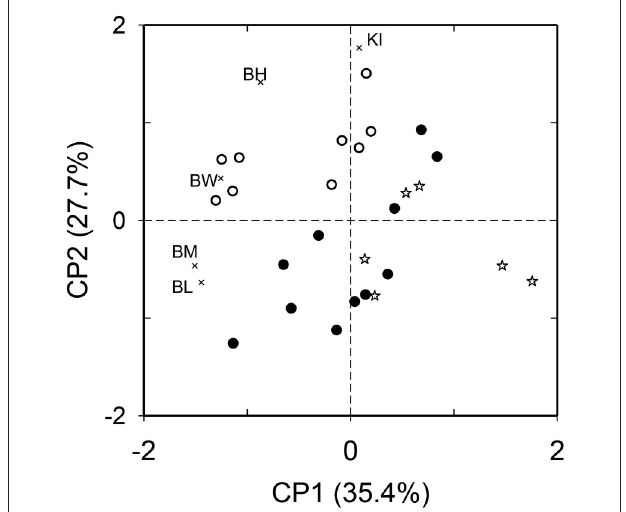
FIGURE 2 | Ordination of 26 bird species that consumed Podocarpus parlatorei fruits in the functional space defined by five morphological traits of size and shape (depicted with thin x; BM, body mass; BL, beak length to wing chord ratio; BW, beak width to wing chord ratio; BH, beak length to beak height ratio; KI, Kipp’s index) in a principal component analysis. Bird functional groups defined by their fruit handling behavior are depicted with open circles (gulpers), filled circles (mashers), and open stars